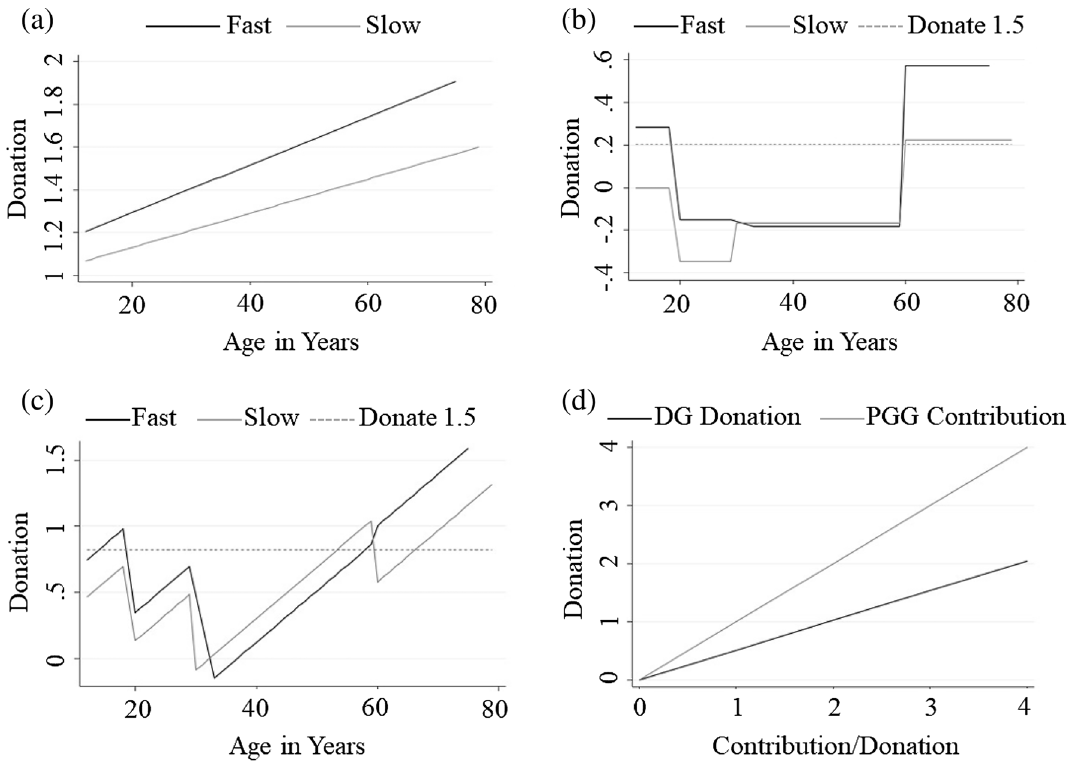
Figure 2. Participants’ Choices in the Dictator Game. Panel ( a ) depicts the OLS estimation of specification (10), with the black line representing estimated donations under time-pressure (fast), and grey line representing estimated donations in the time-delay (slow). Panels ( b ) and ( c ) depict the ordered Probit regressions by age group from Eqs. (11) and (12), with black lines depicting expected donations under time-pressure and grey lines depicting donations under time-delay. In both panels, the dependent variable is rescaled by the ordered Probit approach, and the dashed line represents a donation of 1.5 lottery tickets. The black line in Panel ( d ) depicts estimated DG donations as a function of PGG contribution, showing that on average individuals donated in the DG 51% of what they contributed in the PGG.